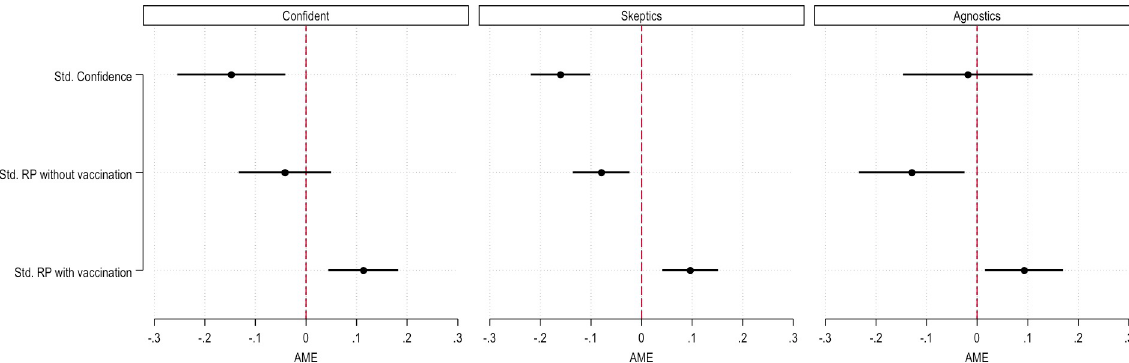
Fig 4. Multivariate binomial logistic regression models predicting the probability to be vaccine hesitant (0 = no hesitancy; 1 = hesitancy). Models are controlled for individuals’ sociodemographic characteristics. Average Marginal Effects. All standardized coefficients. 95% CIs, weighted